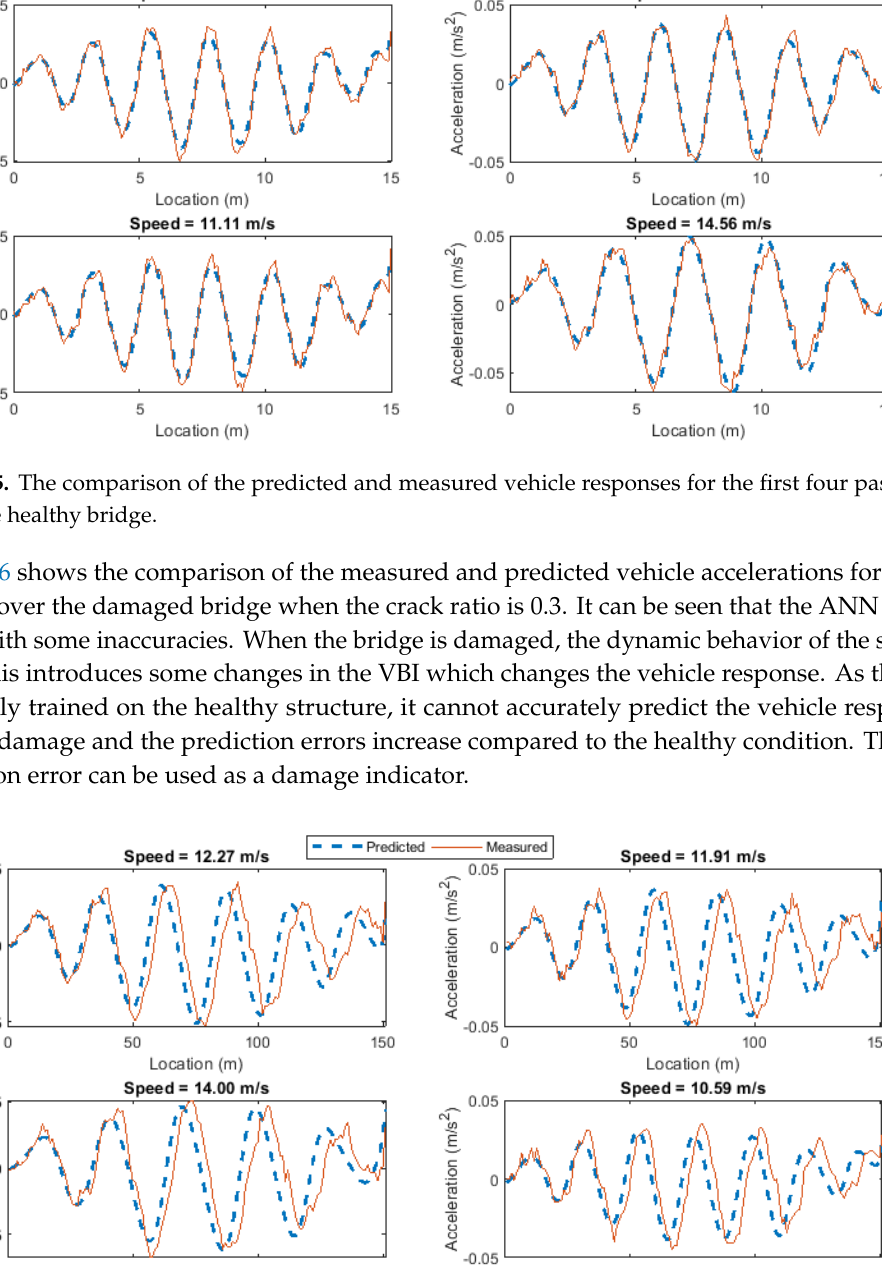
Figure 7. ( a ) The prediction errors and ( b ) DI for the healthy and damaged cases (DI: damage indicator). 4.2. Two Moving Quarter-Cars Passing over a Bridge with Low Road Profile